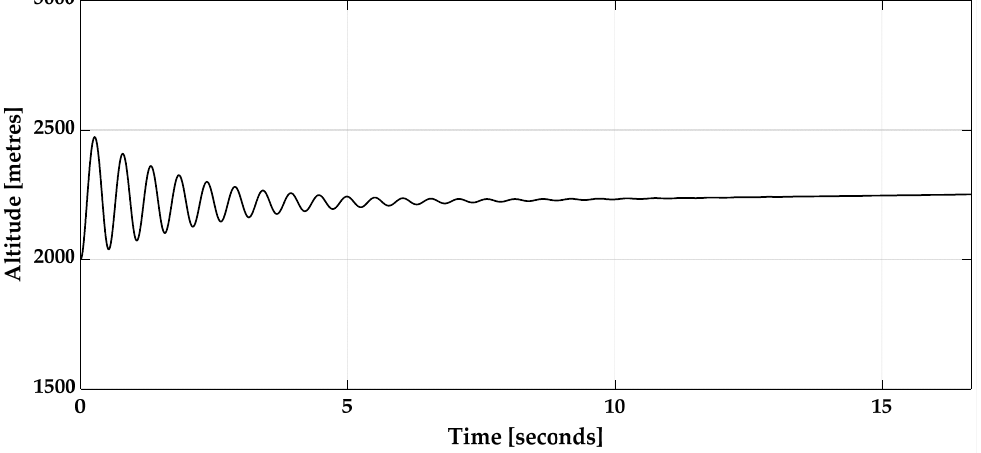
Figure 38. Altitude (h) versus time plot for longitudinal stability case.